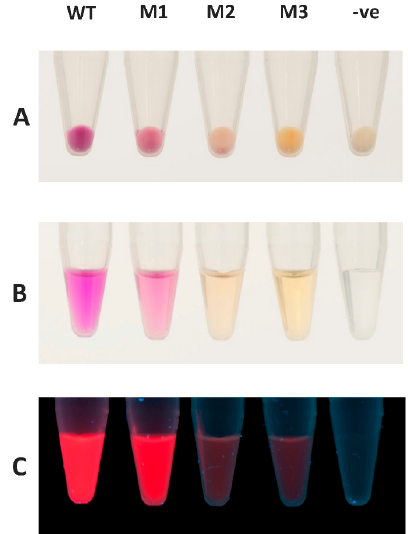
Figure 4. Comparison between mRFP1 wild type (WT) and the three variants (M1, M2, and M3) isolated from the PTO-QuickStep library. ( A ) Cell pellets of E. coli C41 (DE3) expressing the red fluorescent proteins. ( B ) Proteins purified using Ni-NTA Spin Columns (Qiagen). ( C ) Purified proteins under UV light. (-ve) denotes negative control, i.e., E. coli C41 (DE3) without a plasmid.